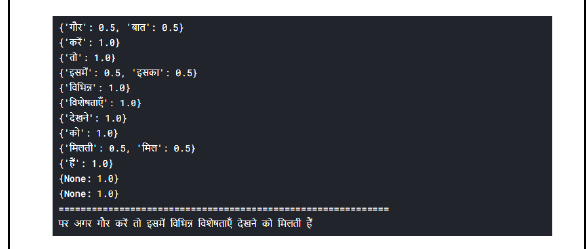
Fig 5.3 Output of with